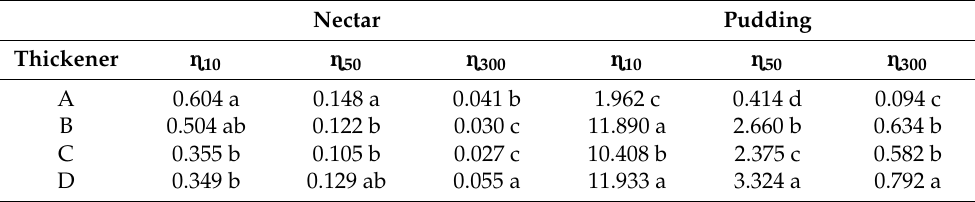
Table 8. Mean values of apparent viscosity for the four thickeners at nectar and pudding levels at a shear rate of 10, 50, and 300 s − 1 .